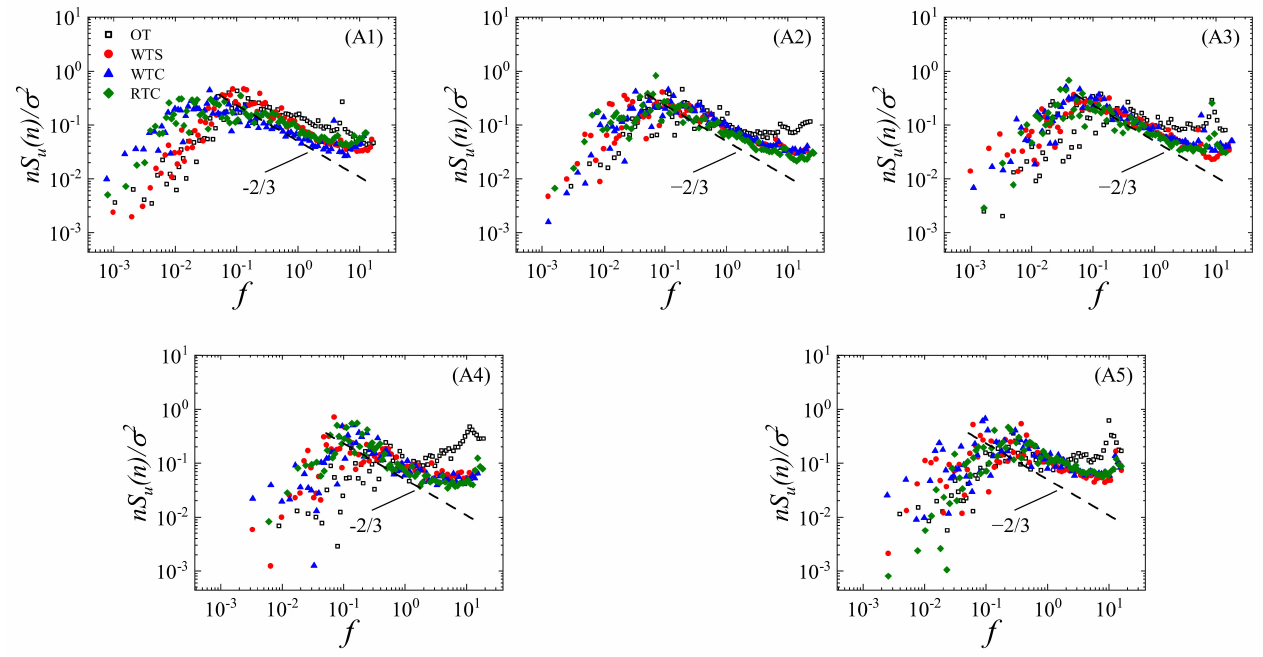
Figure 8. Normalized streamwise spectra for measurement locations at a height of 104 m: (A1) loca- tion A1; (A2) location A2; (A3) location A3; (A4) location A4; (A5) location